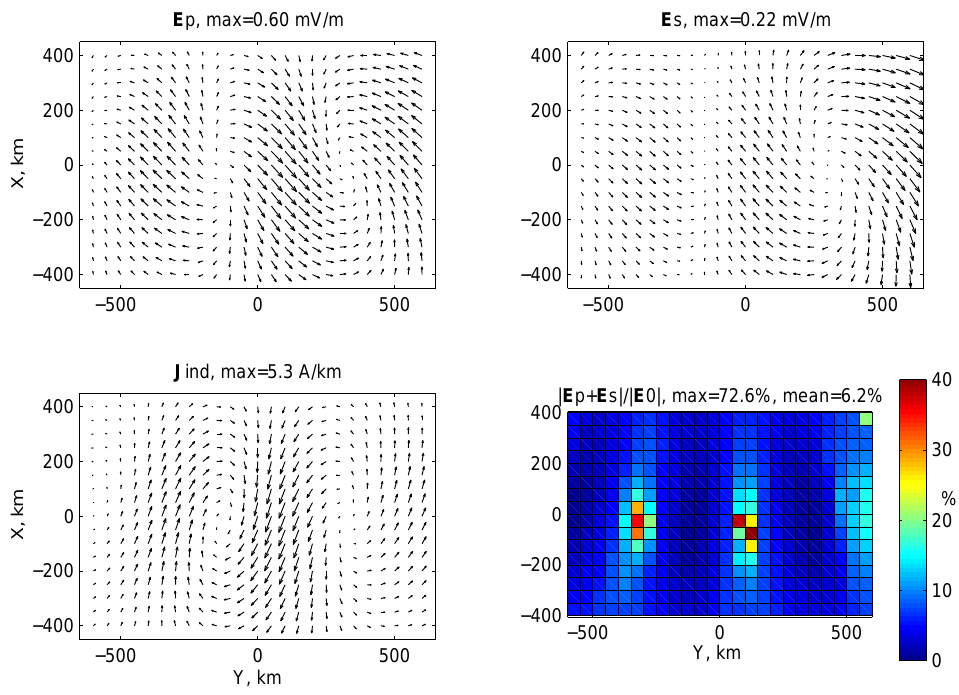
Fig. 8. Same as Fig. 5, but for the Giant Pulsation model. The color scale is limited to 40% while the maximum ratio is 73%. Note the different scales of the vector